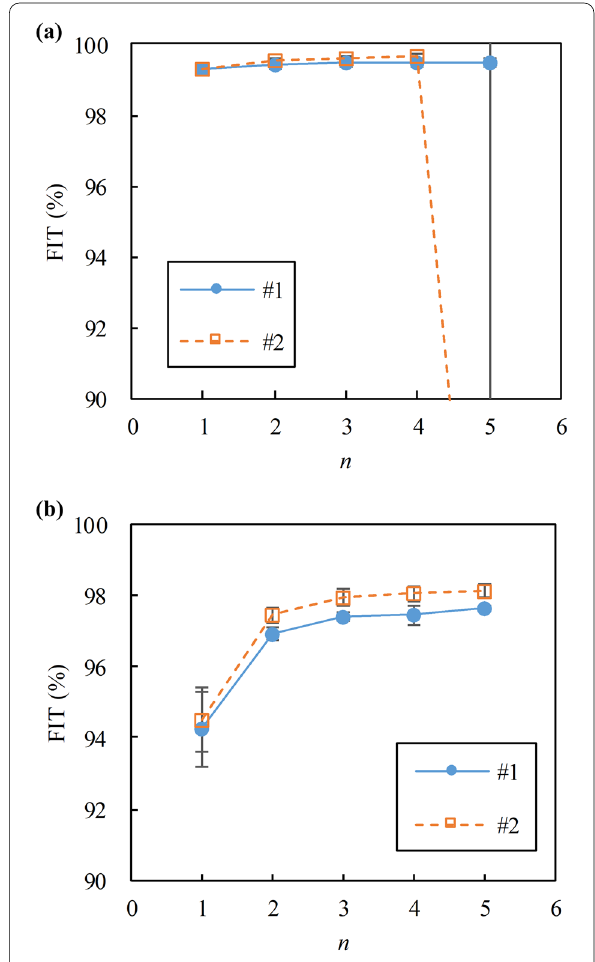
Fig. 12 FIT values for different conditions. a T < T g . b T > T